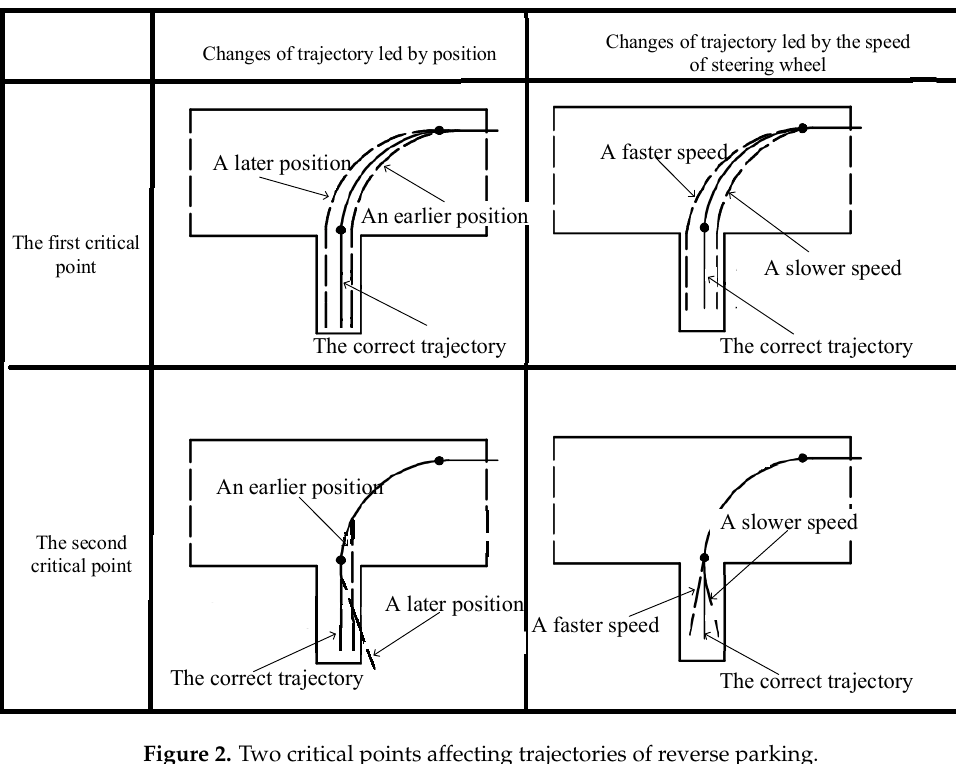
Figure 2. Two critical points affecting trajectories of reverse parking.